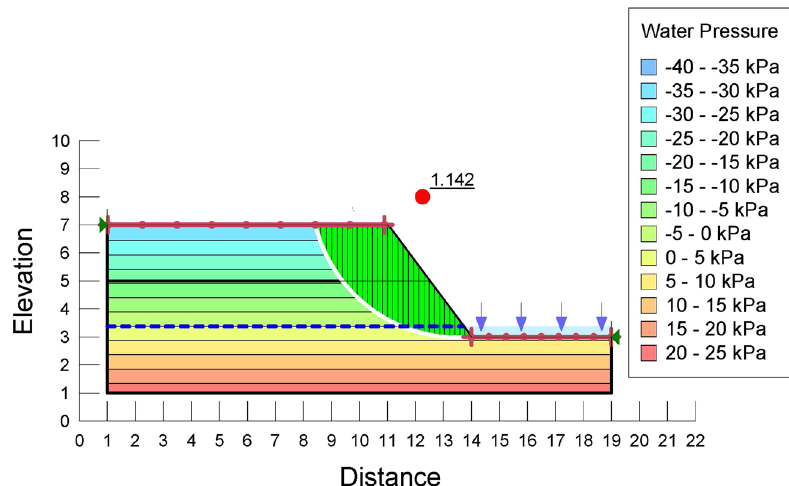
Figure 11: Slope stability for three cycles of applying rationing